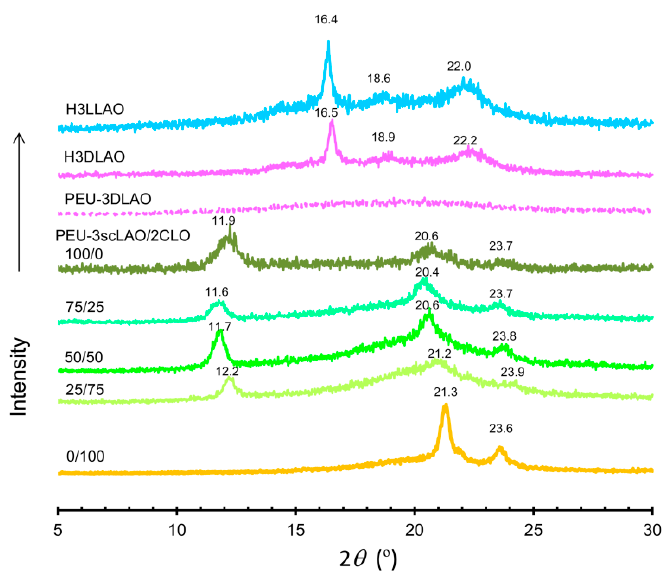
Figure 4. XRD profiles of H3LLAO, H3DLAO, PEU-3DLAO and PEU-3scLAO/2CLOs (100/0, 75/25, 50/50, 25/75 and 0/100). Table 1. Data collected from the first heating DSC curves of H3DLAO, PEU-3DLAO, H3scLAO and